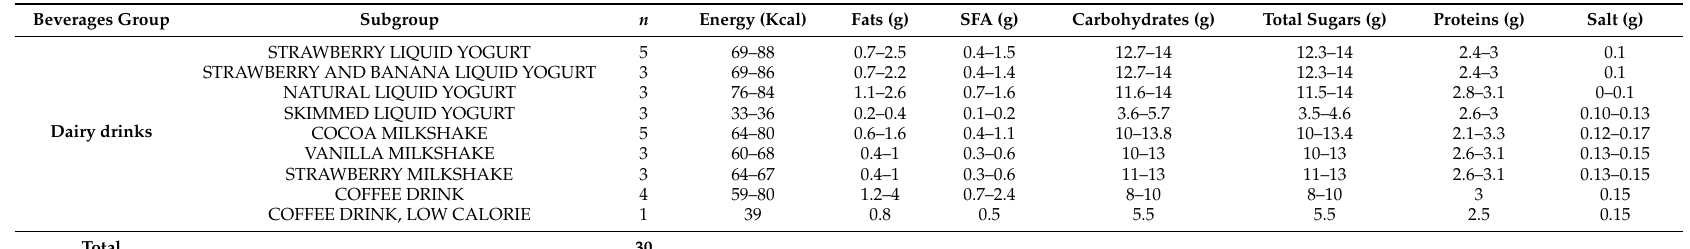
Table 8. Nutrition facts from the “dairy drinks” group in the Spanish food